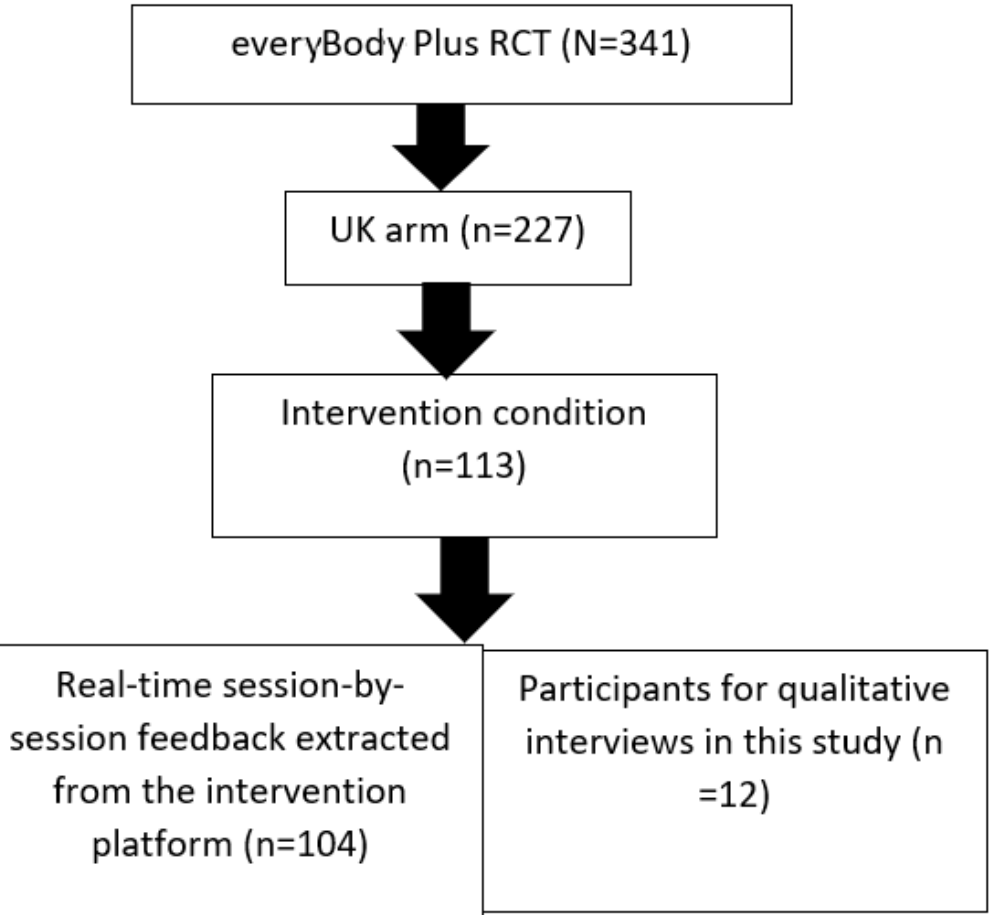
Figure 2. Participant and data breakdown in the current study. RCT: randomized controlled